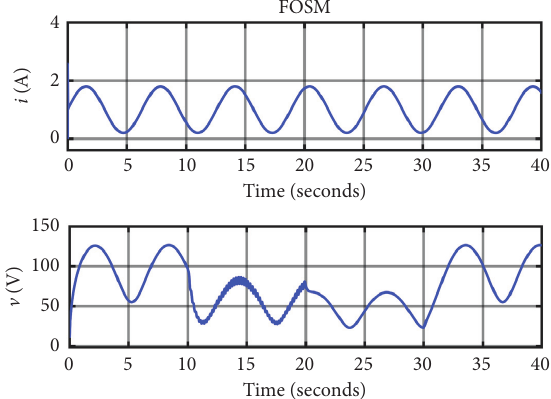
Figure 5: Boost current and voltage with the SSTA controller.